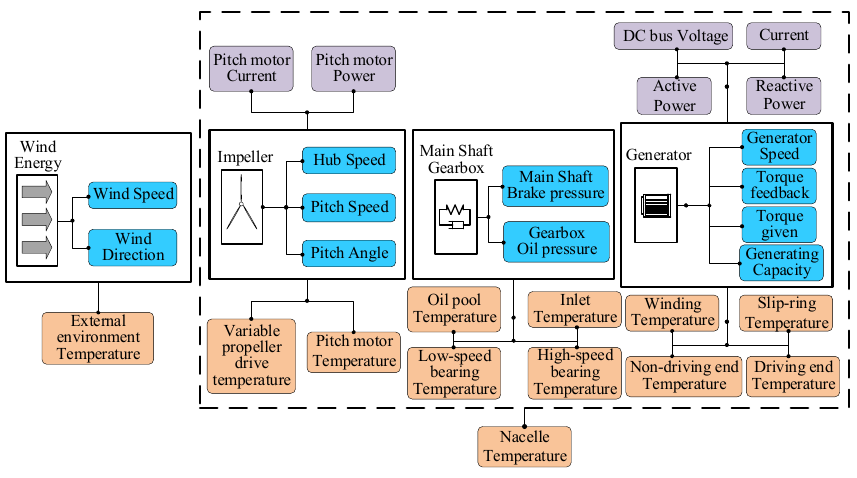
Figure 2. Main parameters of the drivetrain.